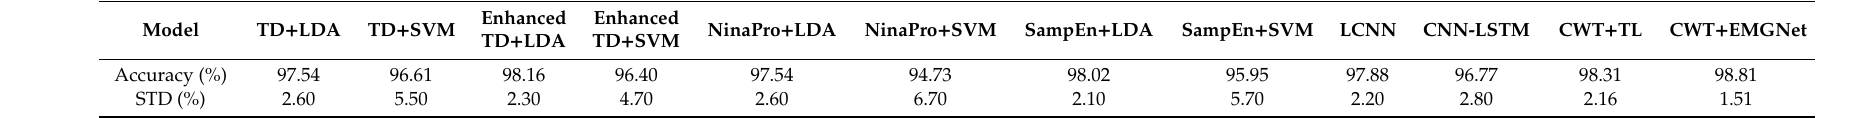
Table 3. Classification accuracy on the Myo Dataset. (We used the same samples to test these